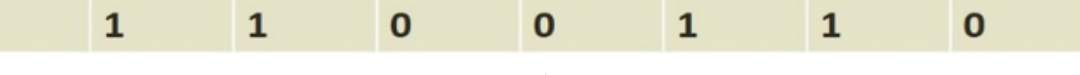
Figure 4. Population Type.